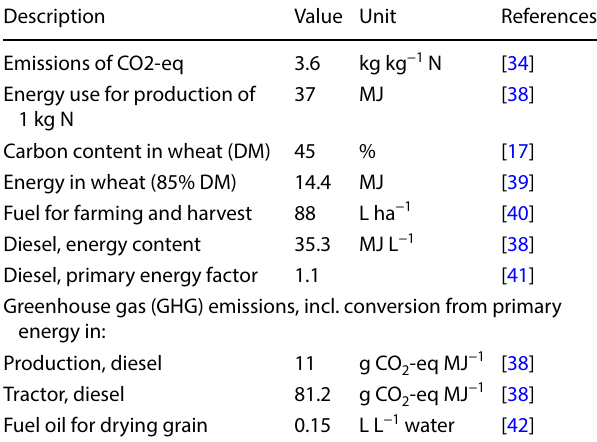
Table 2 Data used for calculating the net effect of mineral nitrogen fertilizer Description